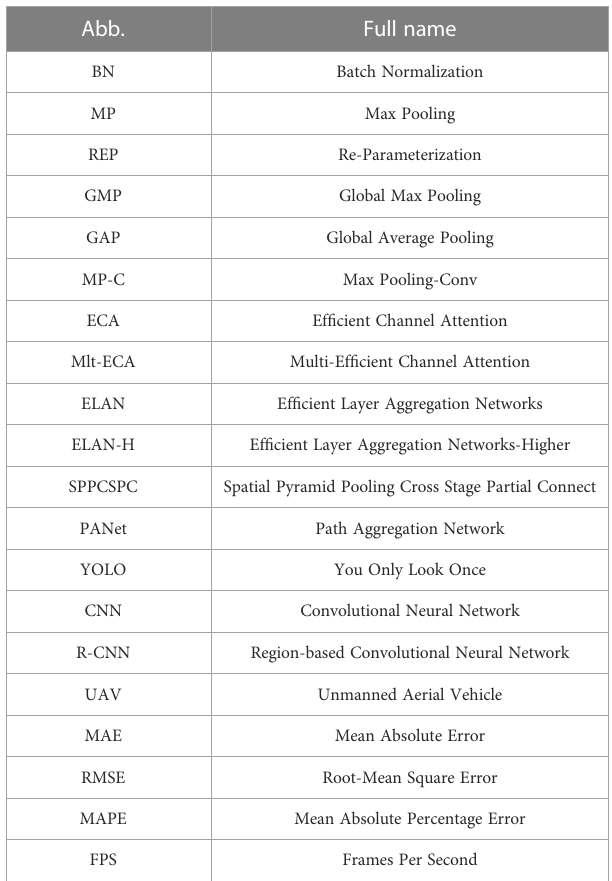
TABLE 1 Summary of